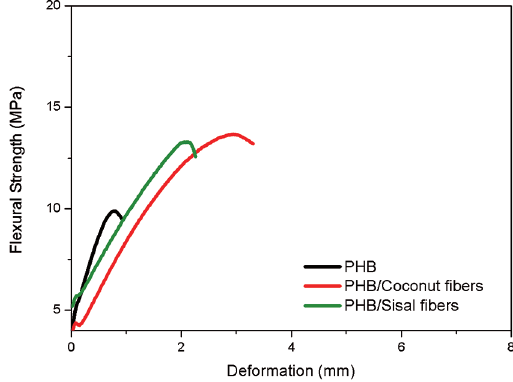
Figure 11: Representative mean curves from flexural test of PHB composites and the PHB without fibers after conditioning a humid